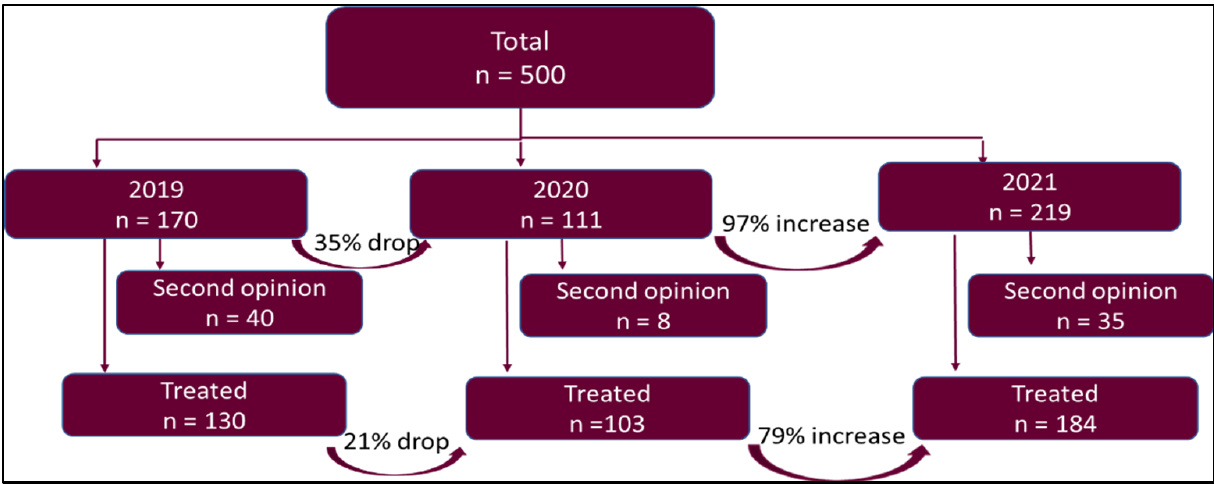
Figure 1. Patient flow chart.